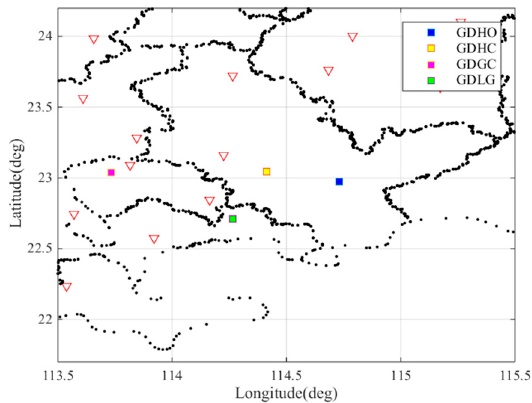
Figure 8. Location of nearby stations of GDHO, GDHC, GDGC and GDLG.